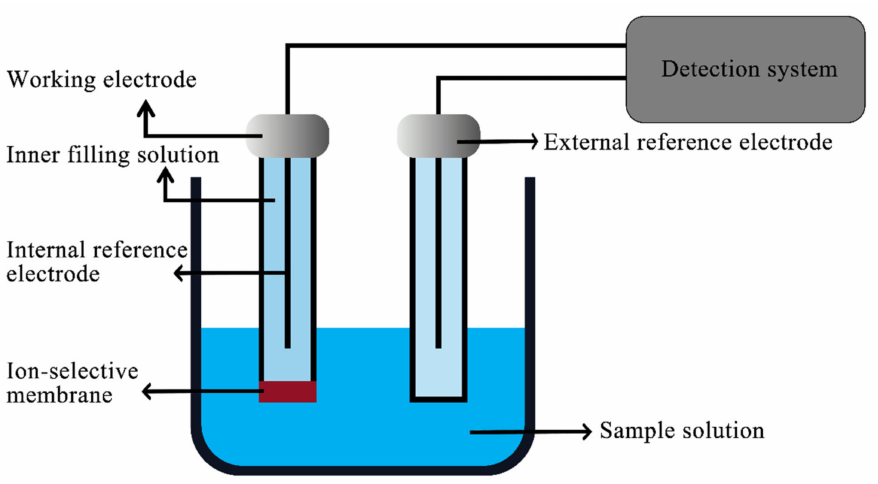
Figure 1. Schematic diagram of ion